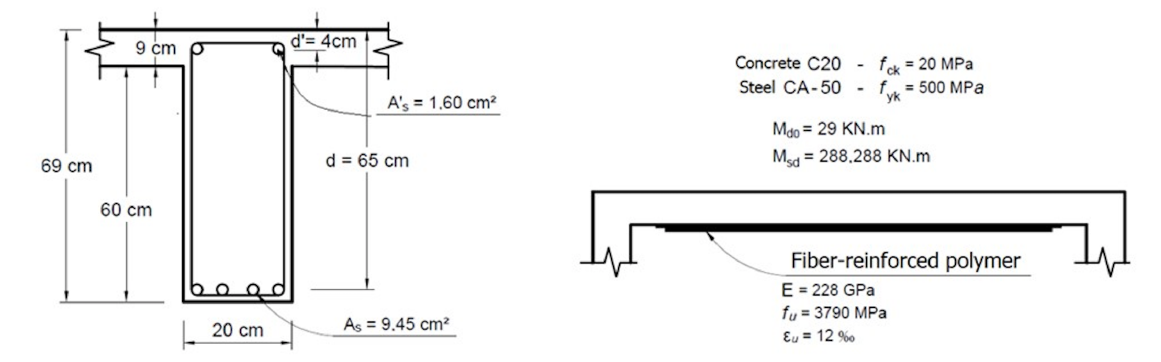
Figure 3. Strengthened beam scheme. Source: Adapted from Machado